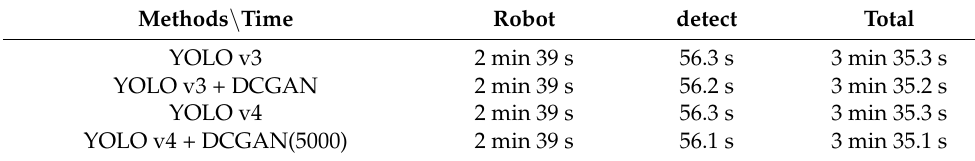
Table 6. Computational efficiency of the proposed automated detection